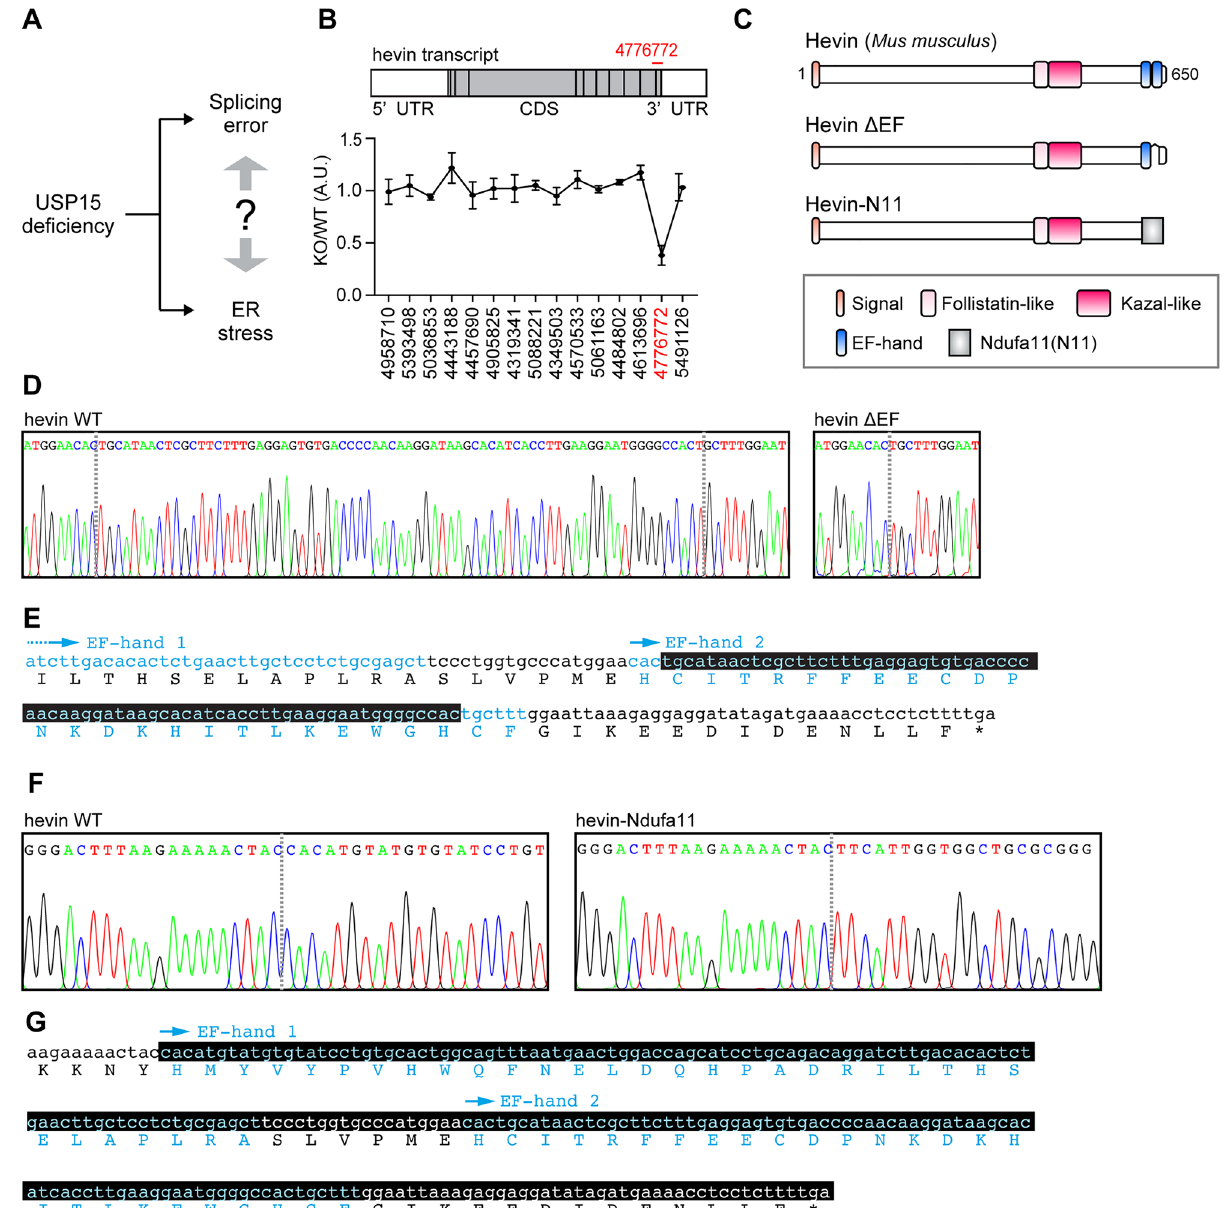
Figure 1. Hevin mutants lacking the EF-hand motif are generated in the Usp15 -deficient brain. ( A ) The relationship between the splicing error and ER stress in the Usp15 -deficient brain has not yet clarified. ( B ) Schematic structure of the hevin transcript in the Usp15 -deficient mouse brain. The 3’-region of the hevin transcript (PSR/Junction ID: 4,776,772) is prone to be missing in the Usp15 -deficient brain. ( C ) The putative schematic structures of Hevin mutants. ( D – G ) Sequence analyses of the 3’-regions of hevin transcripts. ( D ) DNA sequencing chromatogram of the 3’-region of hevin WT and ΔEF transcripts. ( E ) The 3’-region of hevin sequence. Black box indicates the lacking sequence in ΔEF mutant. Cyan indicates the EF-hand motif. ( F ) DNA sequencing chromatogram of the 3’-region of hevin WT and Ndufa11. ( G ) The 3’-region of hevin sequence. Black box indicates the lacking sequence in the Hevin-N11 mutant. Cyan indicates the EF-hand